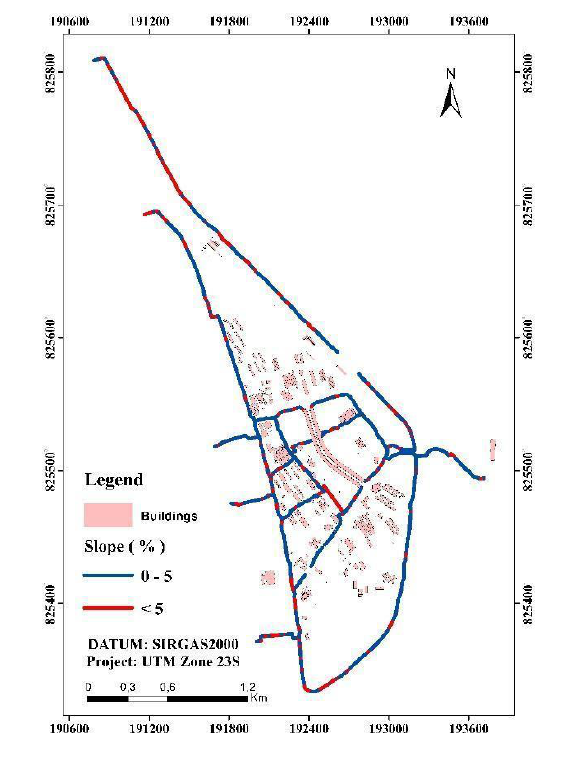
Figure 4: Bicycle path slope map Source: The Authors